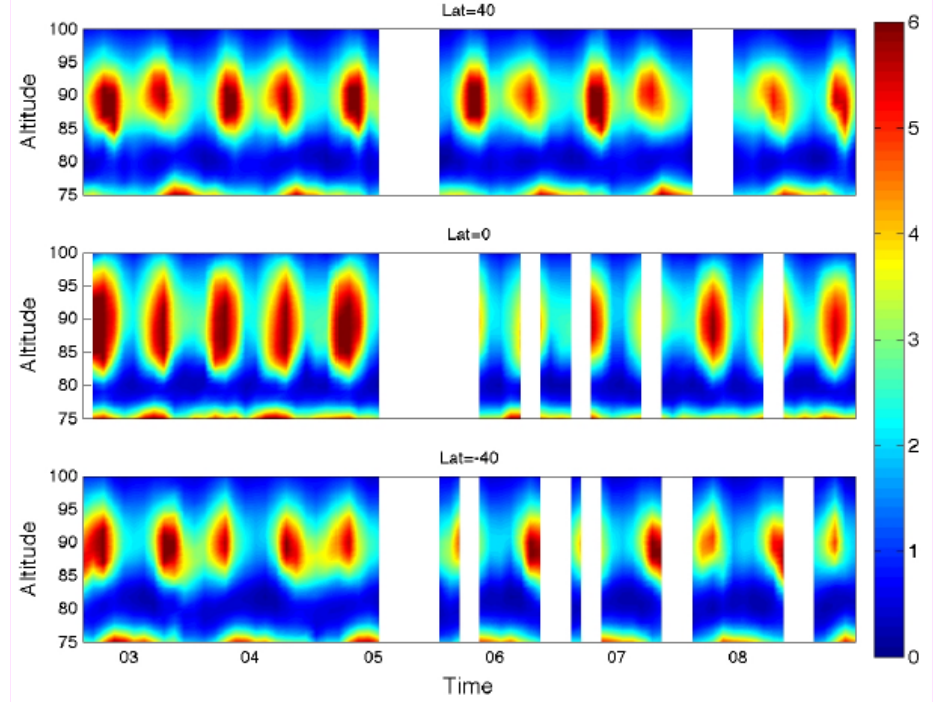
Fig. 27. Ozone number density (scaled by 10 8 cm − 3 ) in the MLT at three latitude belts in 1 August 2002–31 December 2008. Top: 30 ◦ N–50 ◦ N, Middle: 10 ◦ S–10 ◦ N, Bottom: 30 ◦ S–50 ◦ S (from Kyr¨ol¨a et al., 2010b).